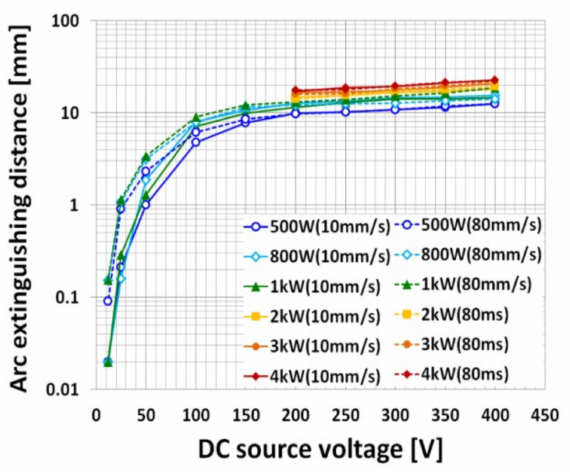
Figure 4. Arc extinction distance under breaking arc according to separation speed, source voltage, and load power conditions.